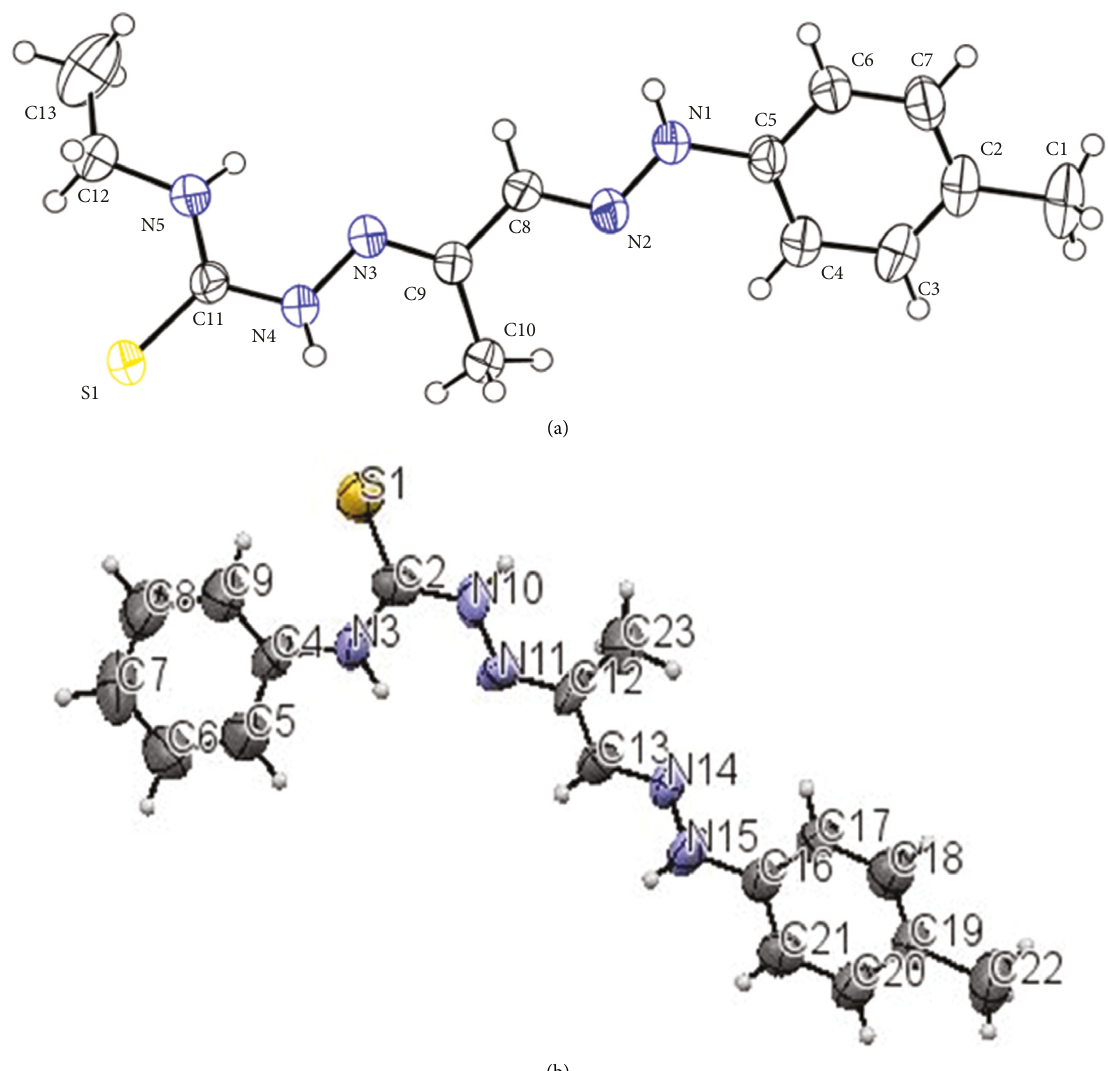
Figure 2: X-ray structure of (a) TSC2 (b) TSC3 along with the atom numbering